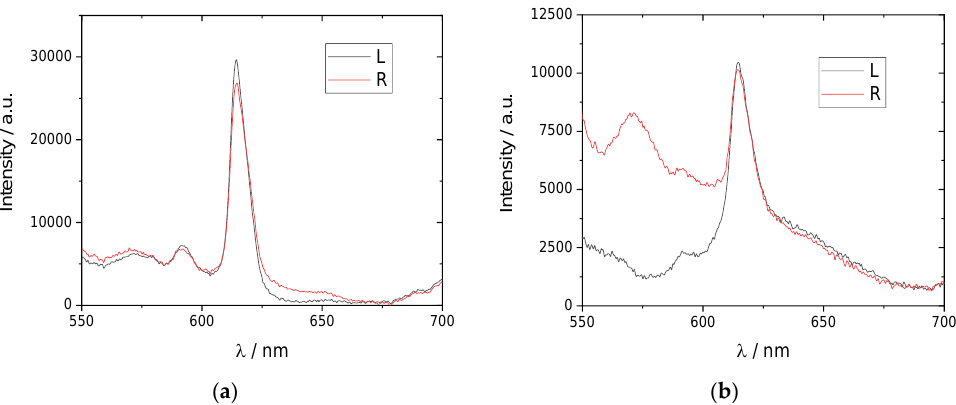
found at temperatures above ca. 90 °C, whereas for the most intense CPL peak at 615 nm, heating results in a decrease in the | g e | values in the range of 70 – 90 °C, followed by a sharp increase. Then, at higher temperatures of ca. 105 – 120 °C, the dissymmetry factor drops to almost zero. Figure 6. Spectra of left- and right-handed circularly polarized luminescence recorded at 90 °C ( a ) and 120 °C ( b ). Excitation: 365 nm LED.